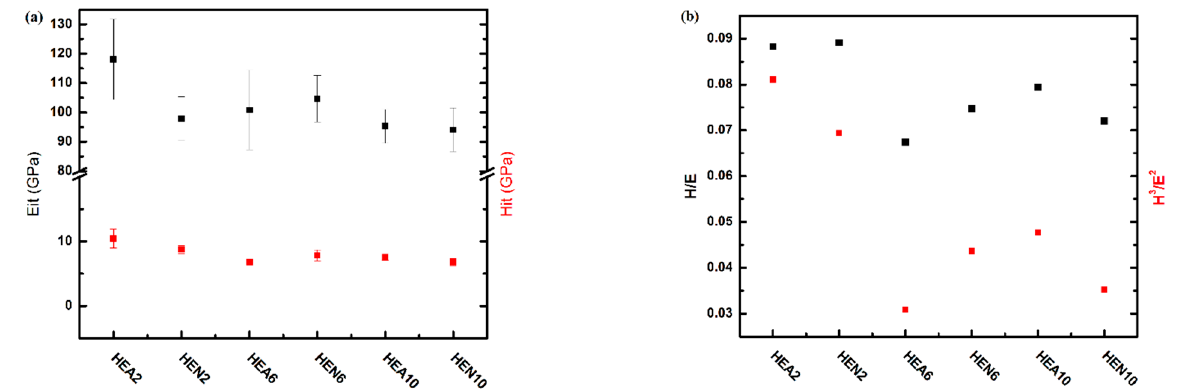
Figure 9. Plotted data on the variation of some measured mechanical characteristics: ( a ) hardness and elastic modulus, and ( b ) H/E ratio and H 3 /E 2 ratio, both as function of HEA and HEN thin films, as obtained by instrumented indentation.